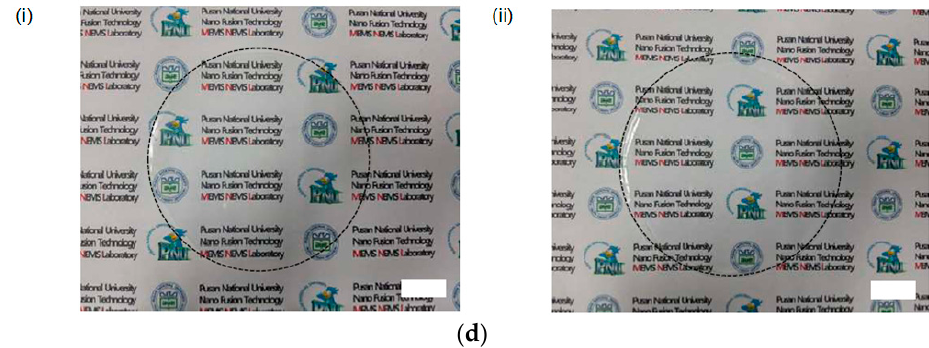
Figure 7. ( a ) Fabrication process of the hierarchically-roughened superhydrophobic films; ( b ) Surface wetting properties of the microroughened and hierarchically-roughened films: ( i ) static contact angle and ( ii ) contact angle hysteresis; ( c ) Transmittance curves measured on ( i ) the microroughened surface and ( ii ) hierarchically roughened films at wavelengths ranging from 400 to 800 nm; ( d ) Photographs of large-area superhydrophobic surface fabricated on ( i ) PET and ( ii ) glass substrates (scale bars: 2 cm). Reproduced from [100] with permission; Copyright ACS 2015.